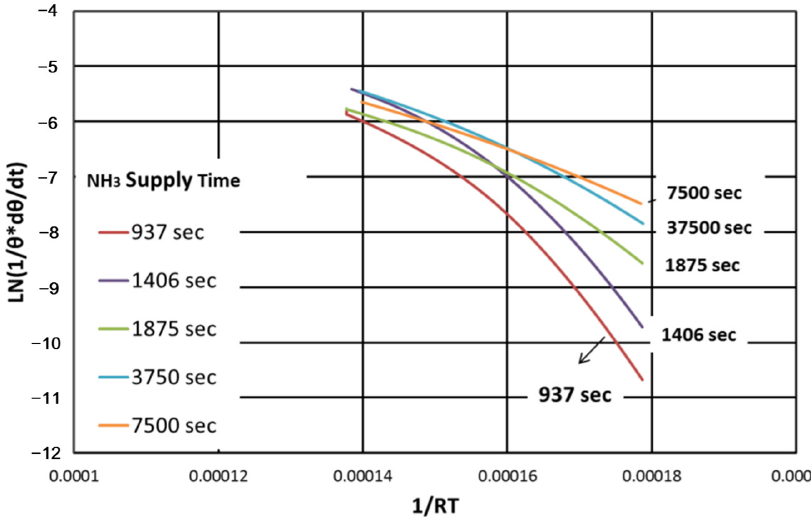
Figure 11. The relationship of the NH 3 desorption rate and temperature for the HT peak. Figure 11 shows the NH 3 desorption rate of the HT peak as a function of ln(1/θ*dθ/dt) versus 1/(RT). The slope of the curve, which represents the activation en- ergy, decreased when the NH 3 supply time was increased. This means that in the SSZ-13 catalyst, various acid sites with different degrees of acidity are widely distributed in the